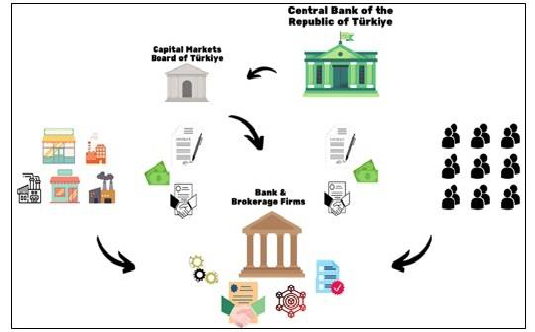
Figure 3. Proposal Model Section 1